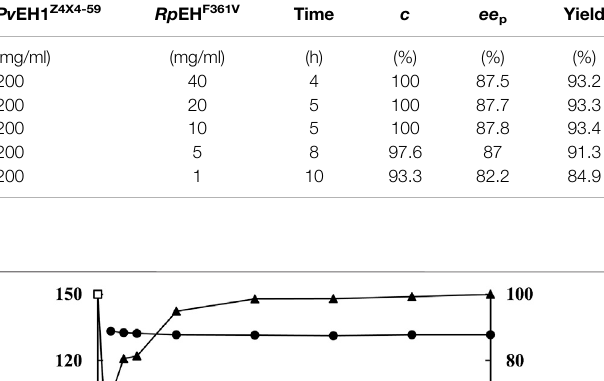
TABLE 1 | The enantioconvergent hydrolysis of rac-p CSO at elevated weight ratios in the 4% (v/v) Tween-20/phosphate buffer system. Pv EH1 Z4X4-59